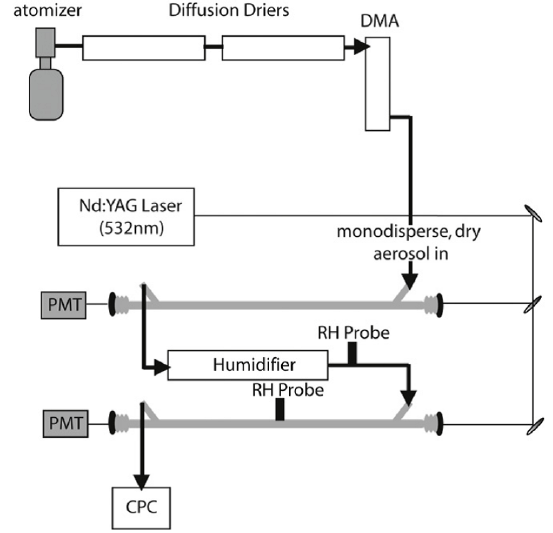
Figure 24. Schematic diagram of the apparatus used by Tolbert and co-workers to measure the dependence of aerosol light extinction on RH. Reprint with permission by Beaver et al. (2008). Copyright 2008 IOP Publishing